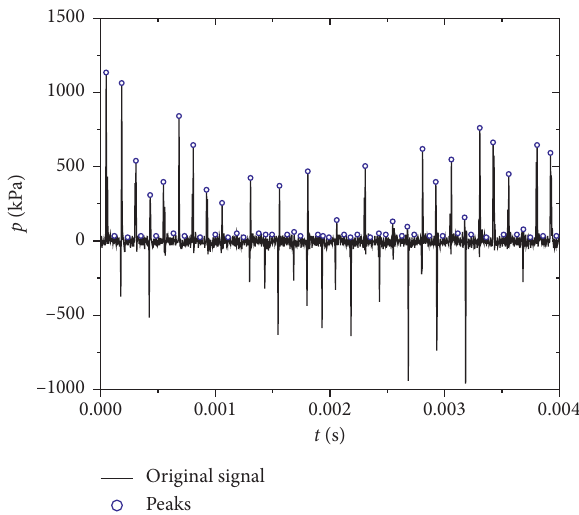
Figure 12: Distribution of the original pressure signal and the